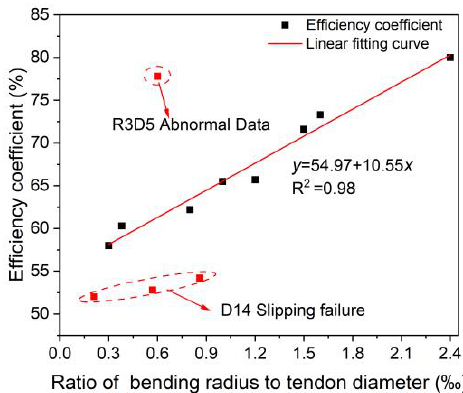
Figure 7. Relationship between the efficiency coefficient and the ratio of the bending radius to the tendon diameter.